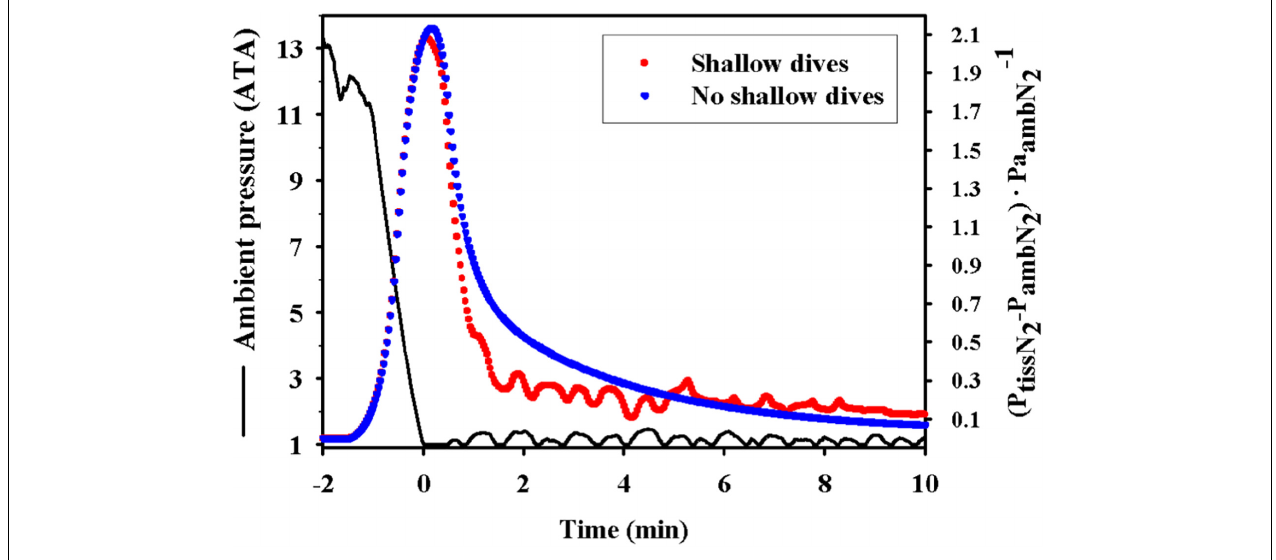
FIGURE 5 | Theoretical effect showing how the short and shallow dive following a series of repeated foraging dives (dive bout) helps to reduce the supersaturation in a king penguin ( Aptenodytes patagonicus ). The figure shows ambient pressure (ATA) and estimated mixed venous supersaturation [(PN 2 v enous –PN 2amb ) · P N 2amb − 1 ] for short and shallow dives (red dots) or no shallow diving (blue dots) follow a dive bout. The figure is reproduced from Fahlman et al.